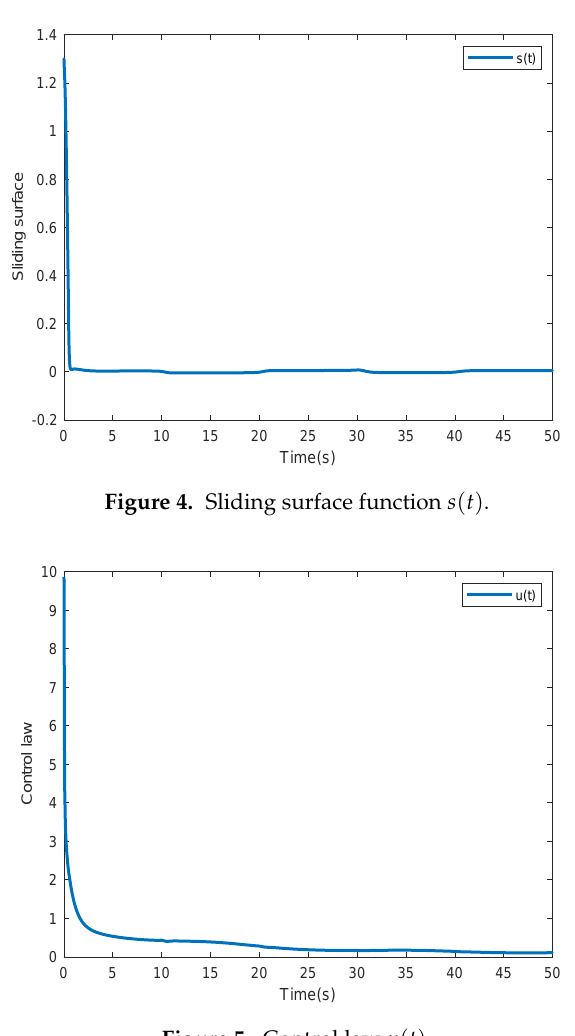
Figure 5. Control law u ( t )